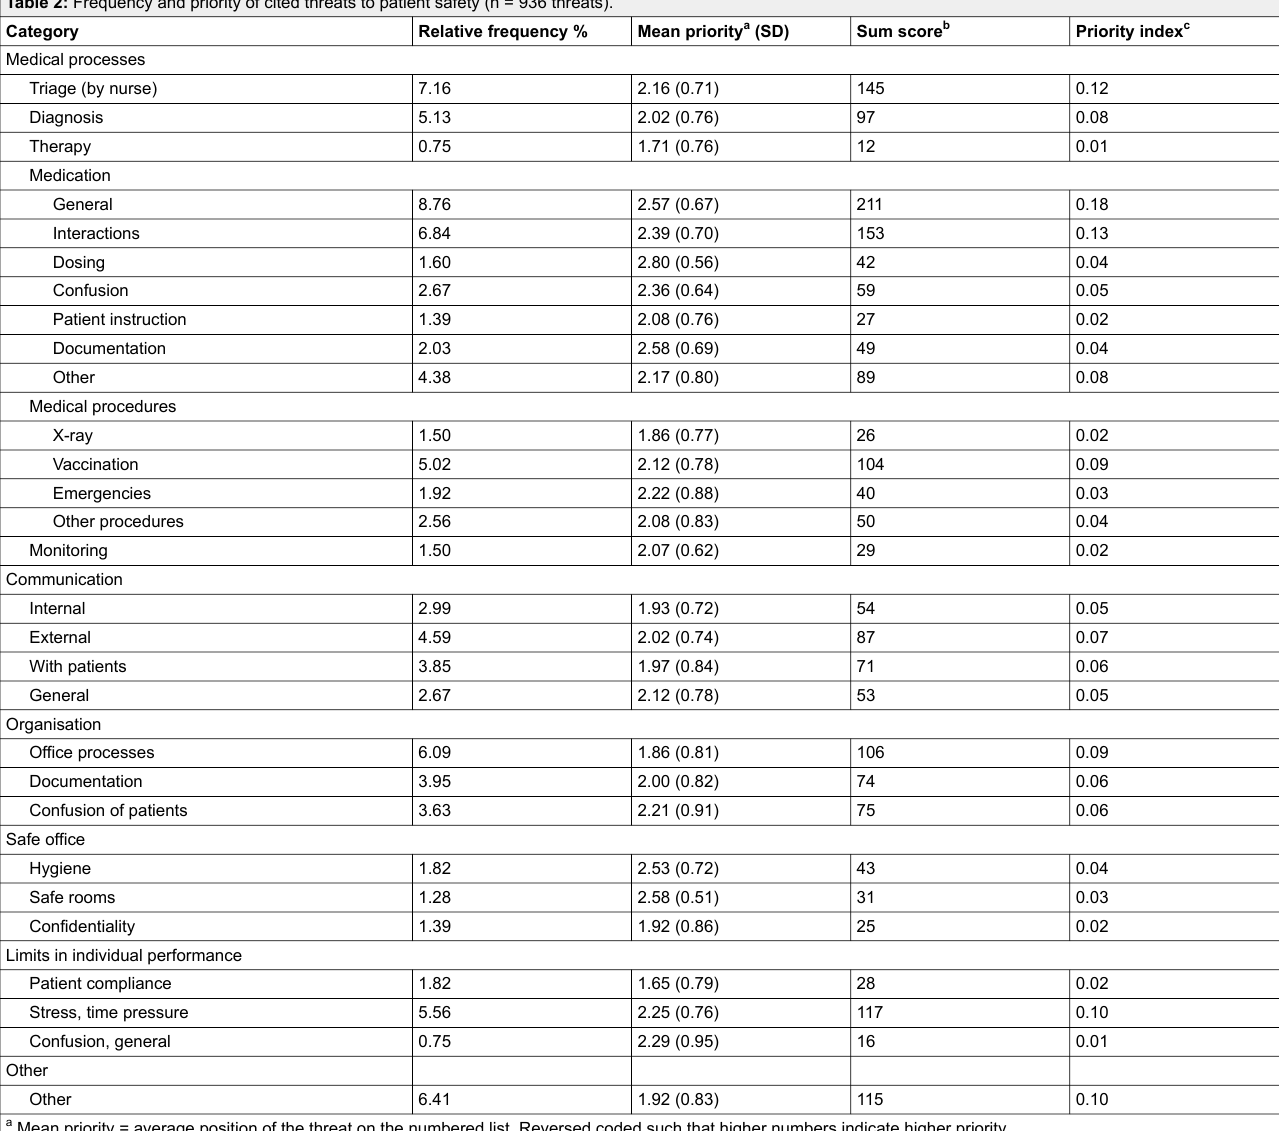
Table 2: Frequency and priority of cited threats to patient safety (n = 936